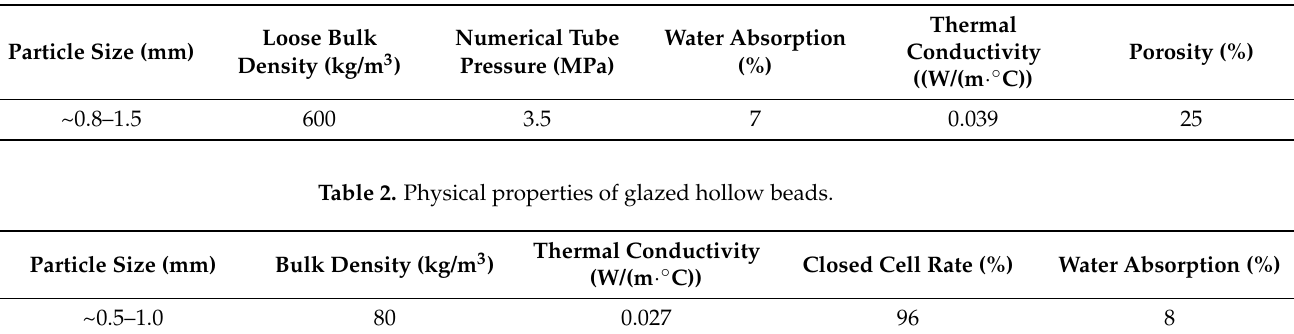
Table 1. Physical properties of ceramsite.